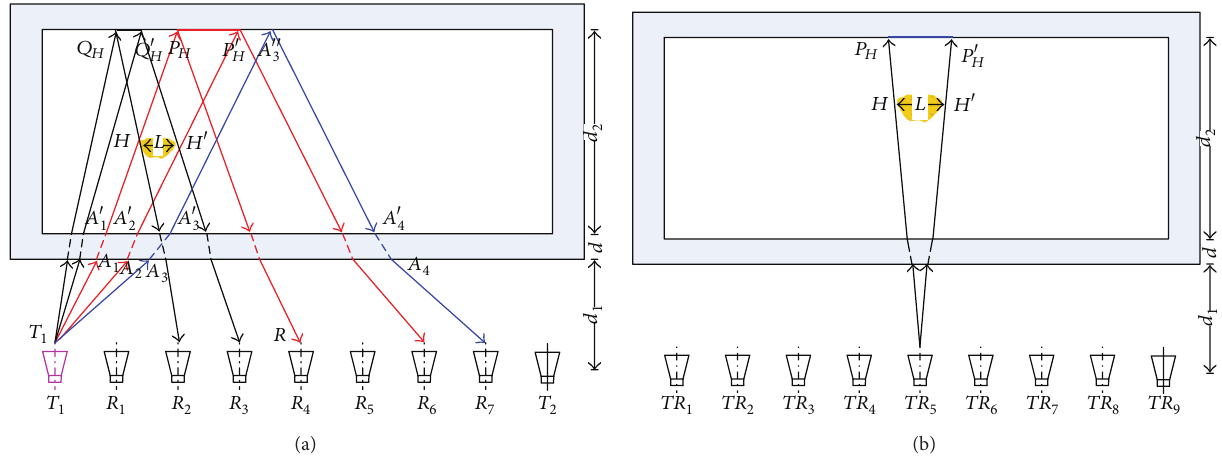
Figure 2: Reflections from the back wall in extended target signal model for the MIMO and monostatic TWI applications. (a) The MIMO mode. In this figure, the antenna array includes two transmitters and seven receivers. For convenience, only the signal channels transmitted by 𝑇 1 are marked. (b) The monostatic mode. In this figure, EM waves emitted by 𝑇𝑅 5 are mainly obscured by the target.